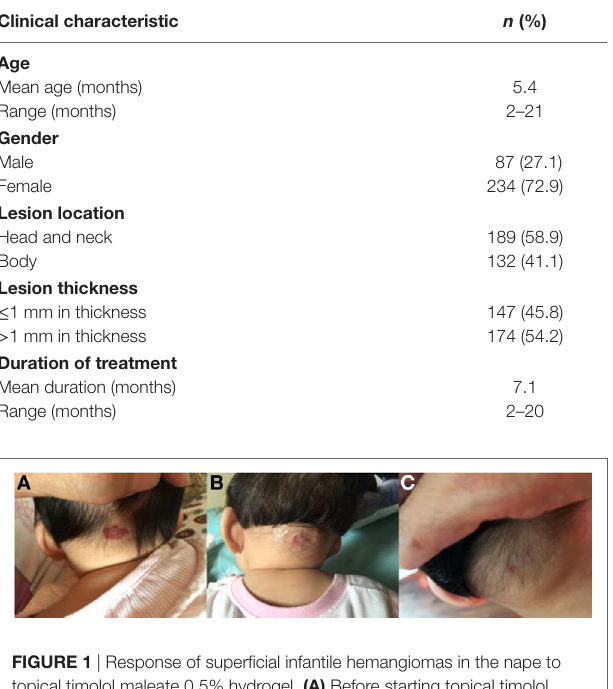
TaBle 1 | Clinical characteristics of